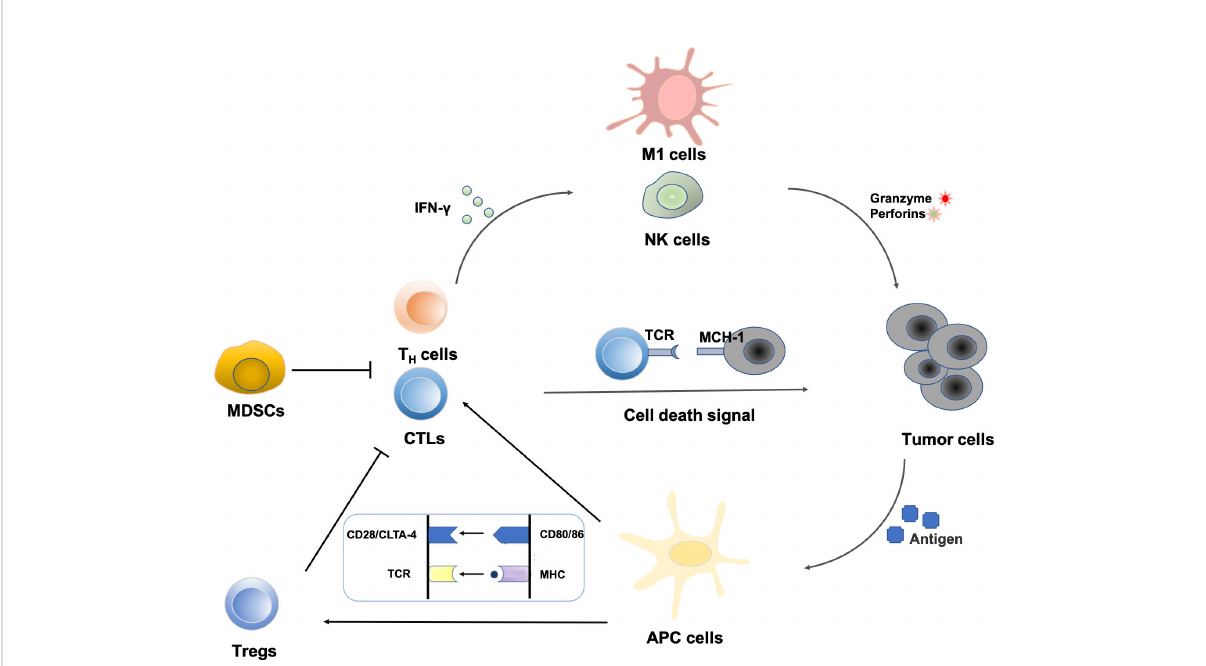
FIGURE 2 Regulation of immune cells in the tumor microenvironment: NK cells represent the fi rst line of defense against a tumor cell. Immunogenic cell death increases the expression of costimulatory molecules (CD80/86) by APCs. Tumor peptide presentation to T cells leads to subsequent activation. CD8+ T cell-mediated elimination of tumor cells occurs via MHC-I recognition. Cytokines from T helper cells enhance the activity of macrophages and NK cells. MDSCs can also create the immunosuppressive cytokines that prevent CTLs and T H cells from attacking